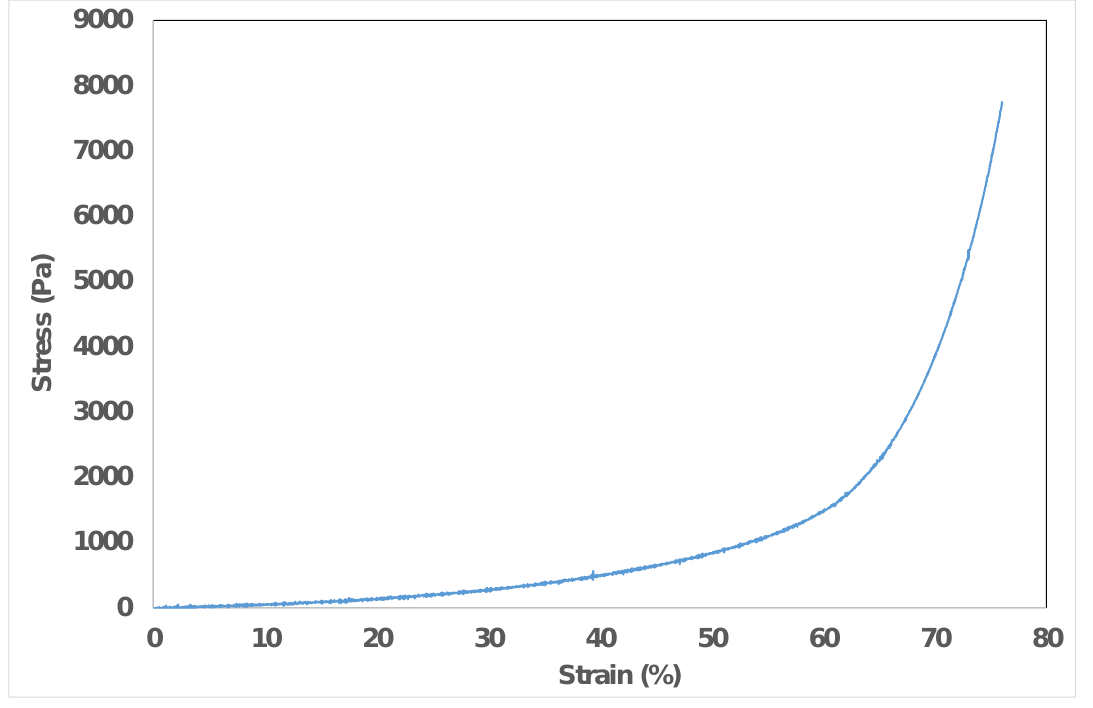
Table 2. Influence of hydrogel on sowing characteristics and growth rates of Lepidium sativum L. variety Ajur seedlings.